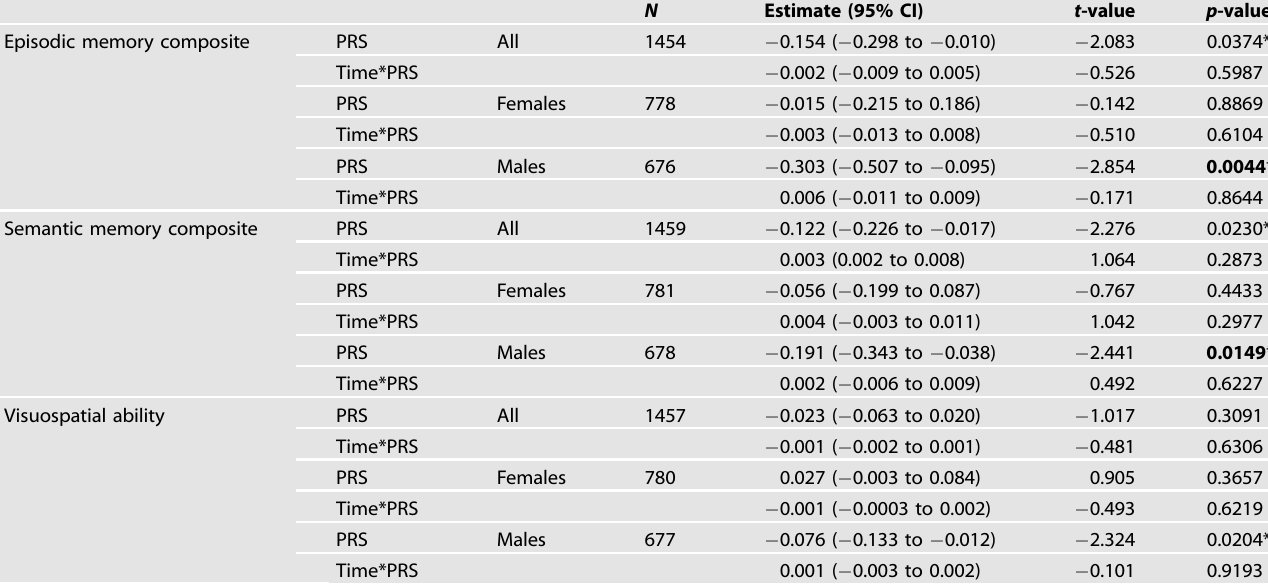
Bold: p < 0.02 (corrected for multiple testing across three tests). Linear mixed-effect models included sex (when applicable), age, age 2 , and the fi rst 5 genetic principal components for genetic ancestry as covariates of no